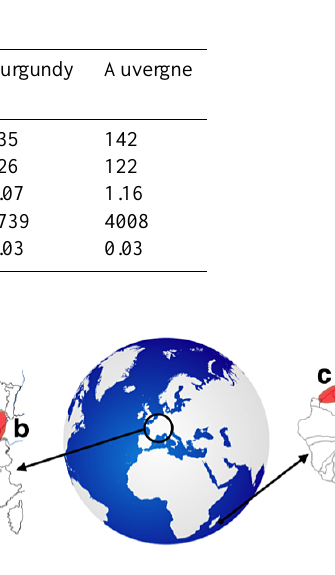
Figure 1. Location of the three sites, corresponding to (a) Au- vergne, (b) Burgundy, and (c) Highway RN1 on